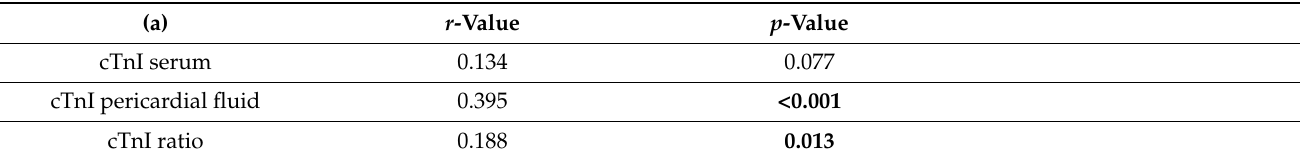
Table 3. (a) Bivariate correlations of cTnI variables and acute myocardial infarction (AMI) death (Spearman correlations) and (b) Mann–Whitney test for cTnI concentrations in AMI diagnostic